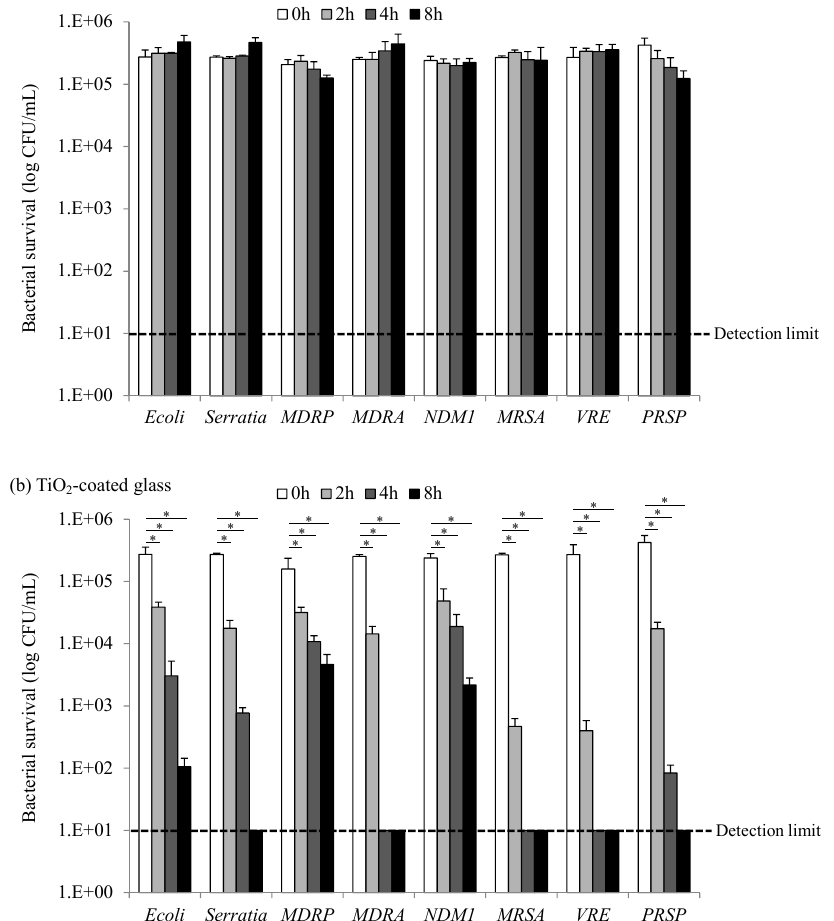
Figure 1. Photocatalytic inactivation of different bacteria with ( a ) control glass or ( b ) TiO -coated glass under black-light illumination (UVA light intensity of 0.1 mW/cm 2 ). 2 The data shown in the figure are the average values of three experiments. Error bars: standard deviations of three replicate experiments. * p < 0.001, 2 h, 4 h, 8 h vs . 0 h exposed to 0.1 mW/cm 2